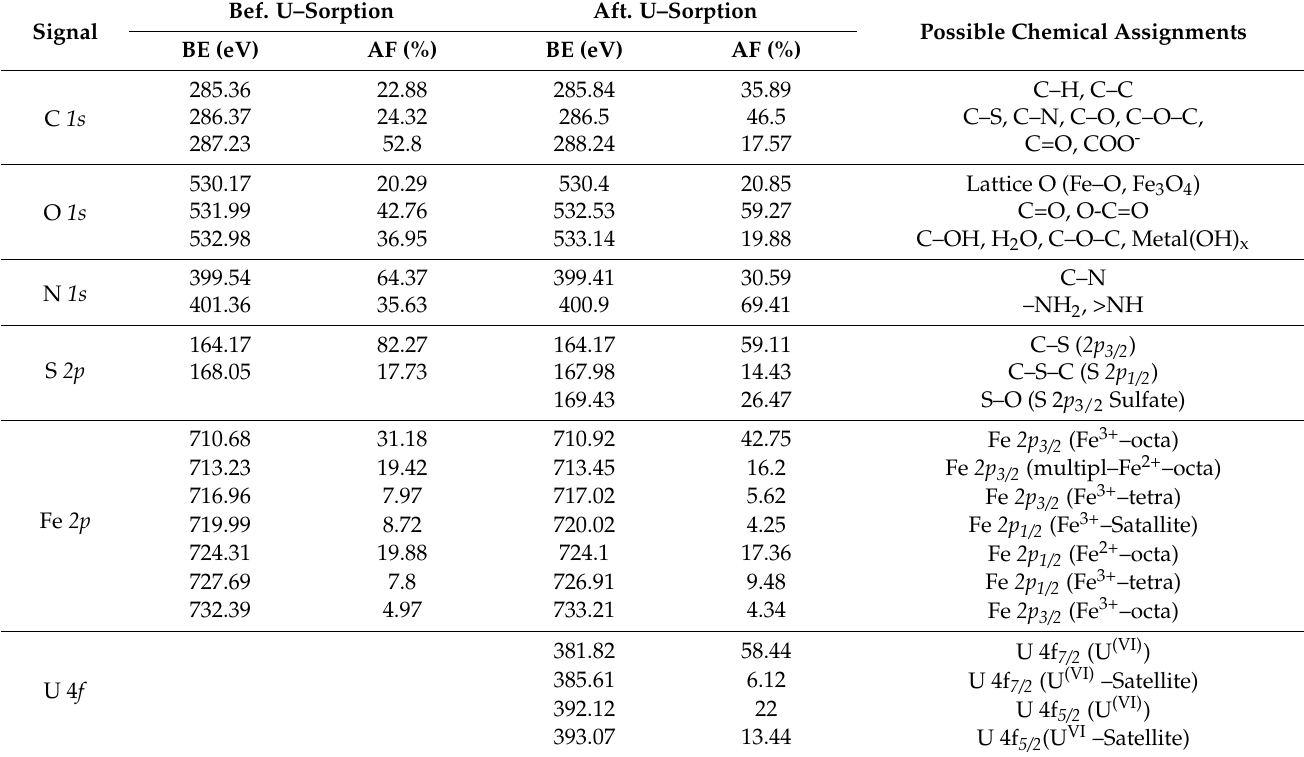
Table 7. Assignment of the core–level signals: Binding energies (BEs) and atomic fraction (AF, %).